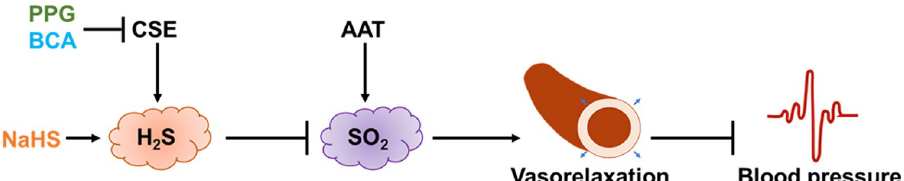
Fig 6. H 2 S negatively controls the plasma content of SO 2 , its vasorelaxant effect and transient hypotensive